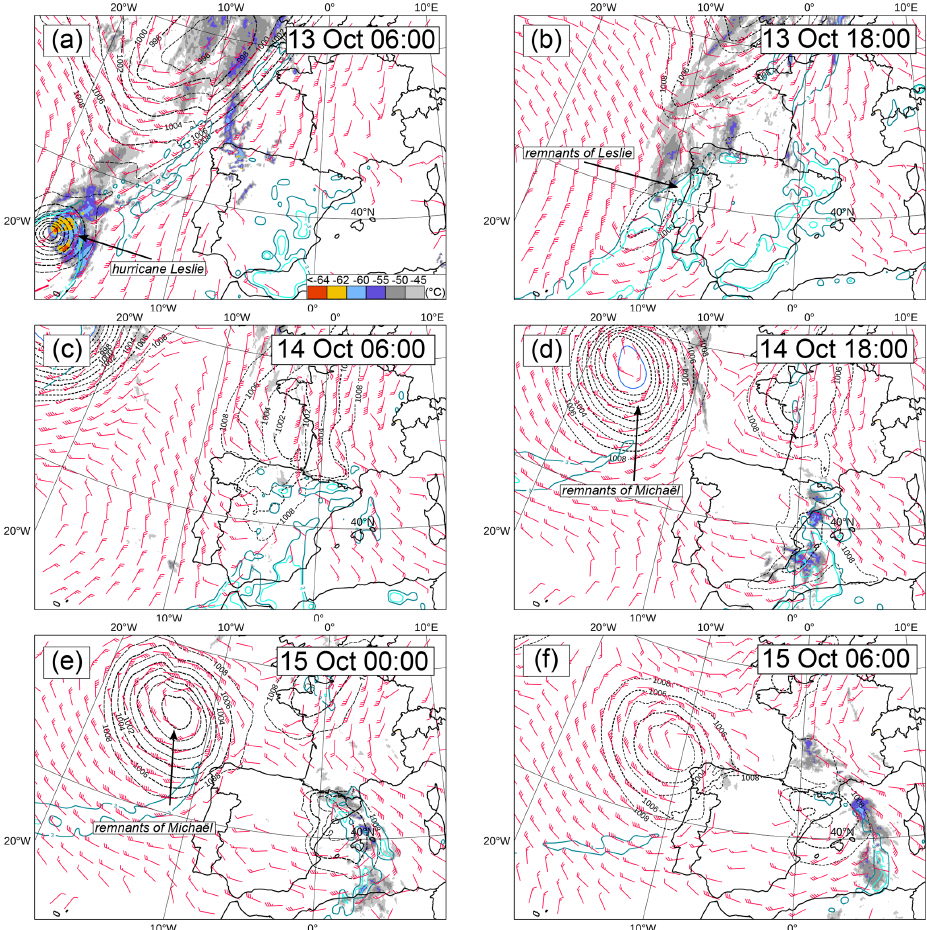
Figure 1. Infrared satellite images superimposed to ARPEGE analysis in terms of mean sea level pressure (dotted lines, hPa), horizontal winds at 925hPa (barbs, knots), and anomalies of specific humidity (solid lines, gkg − 1 ) exceeding 3 and 4 standard deviations, respectively, between 0 and 3km height and over the domain shown in the